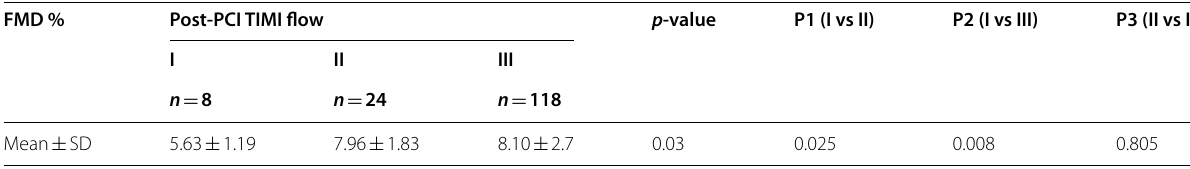
Table 3 Comparing FMD% between post-procedural TIMI flow grades